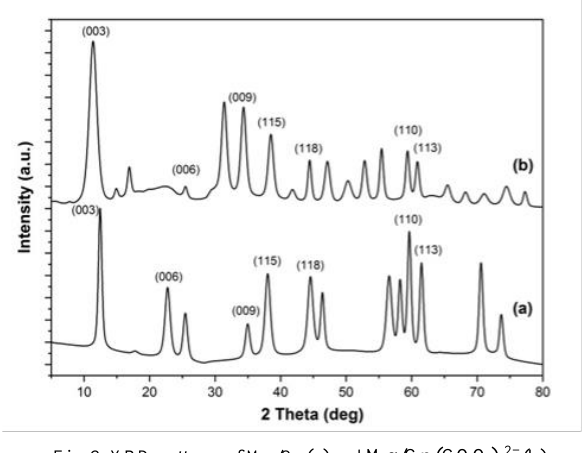
Fig. 2. XRD patterns of Mg/Cr (a) and Mg/Cr-(COO) 22 - (b)